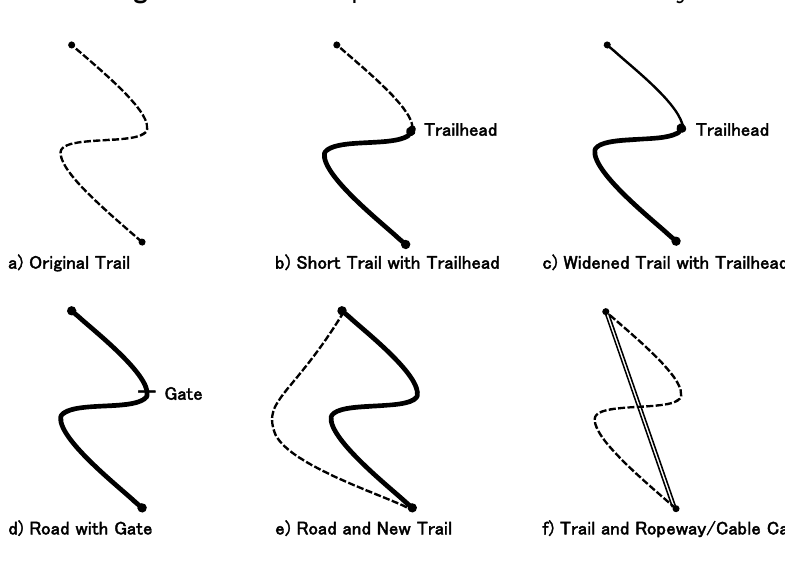
Figure 14. Access options for trail